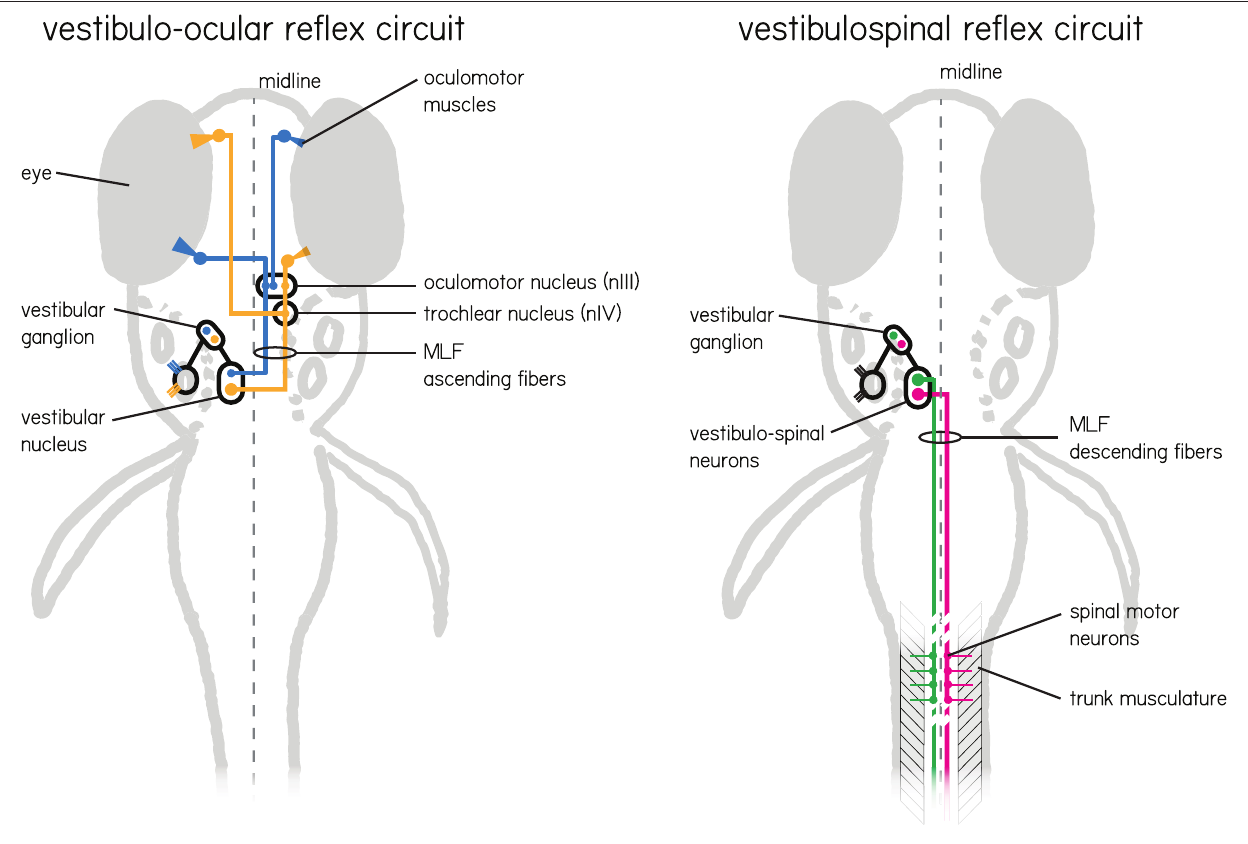
FIGURE 2 | Two vestibular circuits in the larval zebrafish responsible for stabilization of gaze and posture. (Left) The vestibulo-ocular reflex circuit is responsible for stabilizing gaze. Illustrated in color are the primary populations responsible for the vertical and torsional directions of rotation. Nose-up/eyes-down are illustrated in yellow, and nose-down/eyes-up are illustrated in blue. Both channels sense instability with hair cells in the inner ear tuned to a particular direction of linear acceleration. These hair cells relay information to VIIIth nerve vestibular afferent neurons located in the vestibular ganglion, and then in turn to neurons in the vestibular nuclei. Individual vestibular nucleus neurons sent ascending projections along the medial longitudinal fasciculus (MLF) to either cranial nucleus III alone (blue) or cranial nucleus III and IV (yellow) where motor neuron somata send axons to their respective eye muscles. (Right) The vestibulospinal circuit has similar peripheral input, but instead of ascending projections from vestibular nucleus neurons leverages descending projections that also run along the medial longitudinal fasciculus. These neurons (green and pink) comprise the lateral and medial vestibulospinal tracts and project to spinal interneurons and motor neurons which in turn control trunk